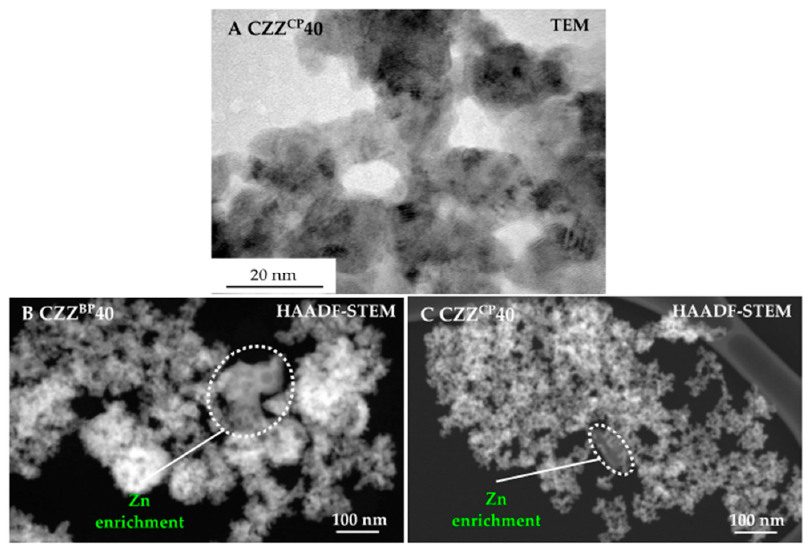
Figure 3. TEM image of ( A ) CZZ CP 40 of a section of 70 × 80 nm, and HAADF ‐ STEM images of ( B ) CZZ BP 40, and ( C ) CZZ CP 40 of a section of 1000 × 950 nm.